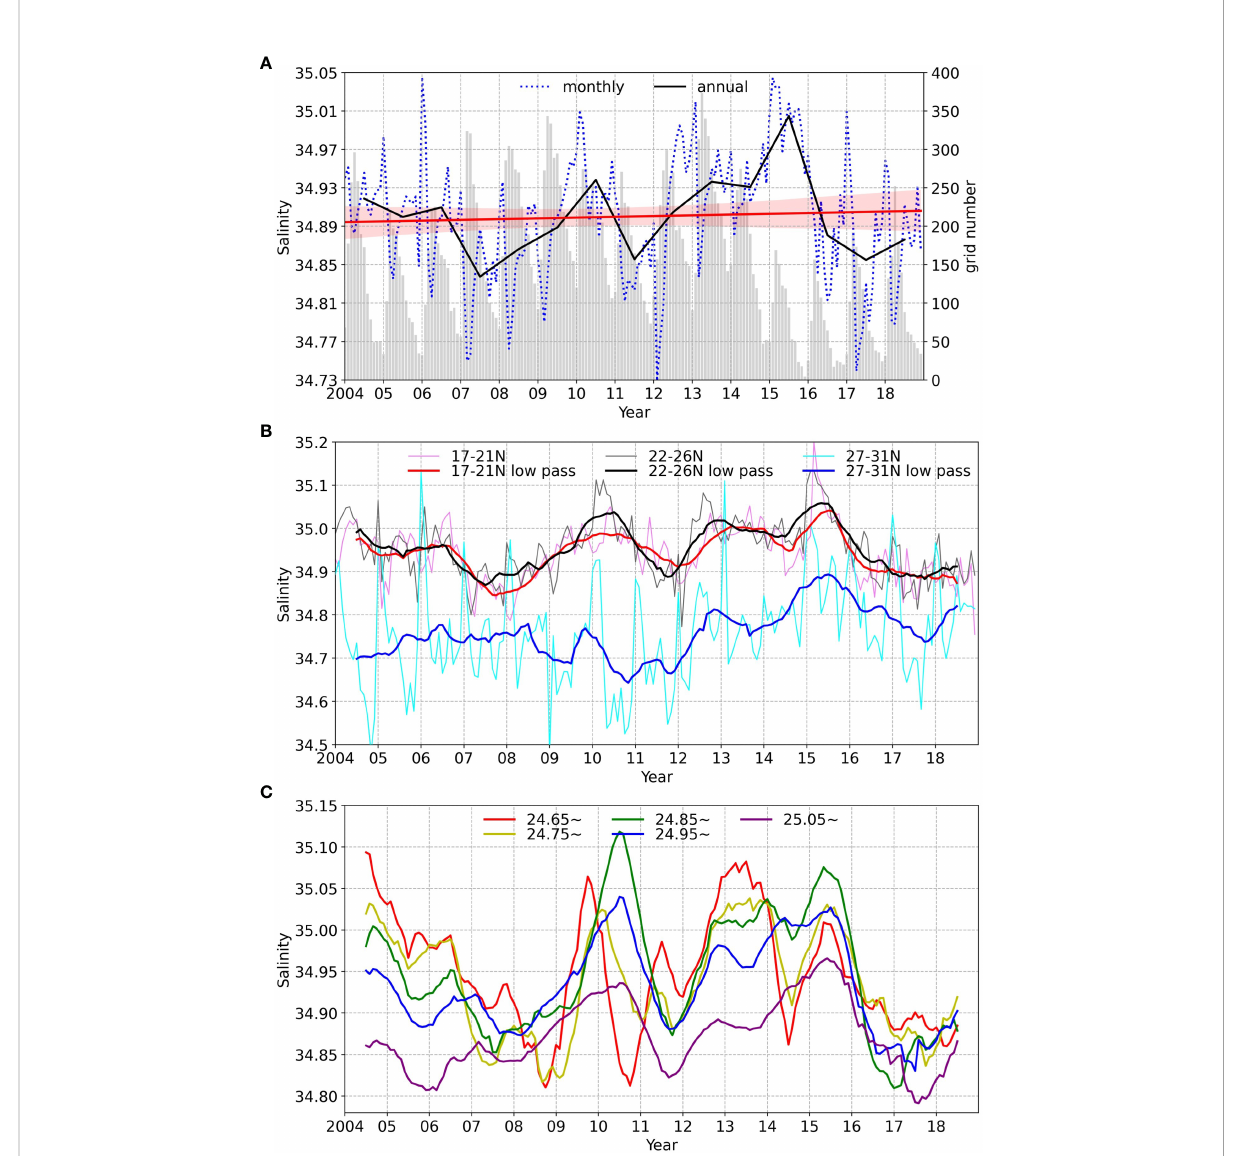
FIGURE 7 Same as in Figure 5 but for ESTMW. (B) In 17 – 21°N (pink and red), 22 – 26°N (gray and black), and 27 – 31°N (light blue and blue). (C) On surfaces at g = 24.65 – 24.70 (red), 24.75 – 24.80 (yellow), 24.85 – 24.90 (green), 24.95 – 25.00 (blue), and 25.05 – 25.15